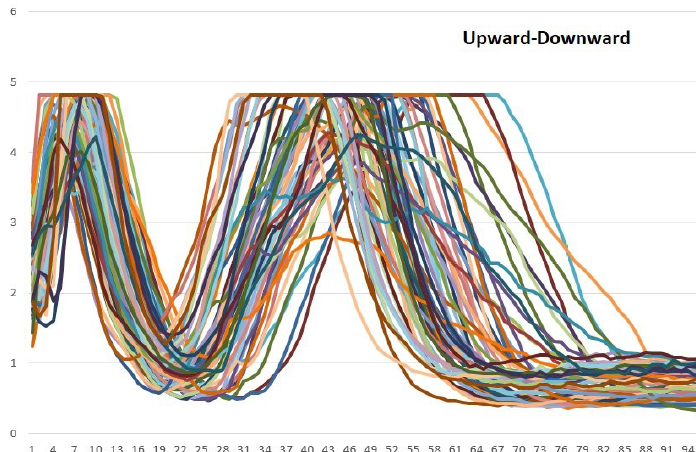
Figure 10. Samples that are related to the upward movement. The Y -axis represents each sampling point of the vector that is related to each sample and the X -axis represents the signal amplitude (it was mapped between 0 and 5). Sensors 2019 , 19 , x FOR PEER REVIEW